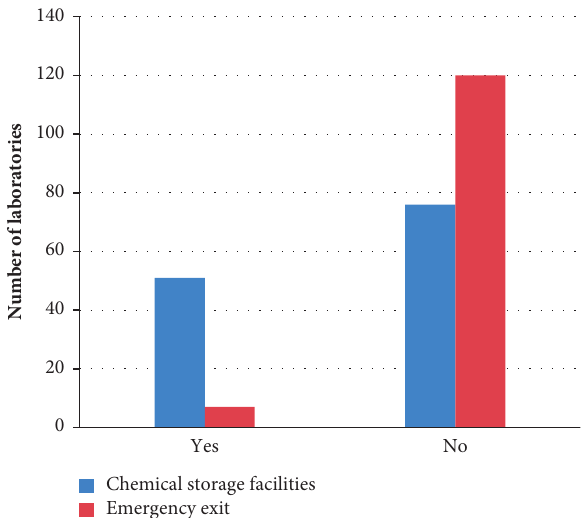
Figure 6: Provision of emergency exits and chemical storage fa- cilities in laboratories.